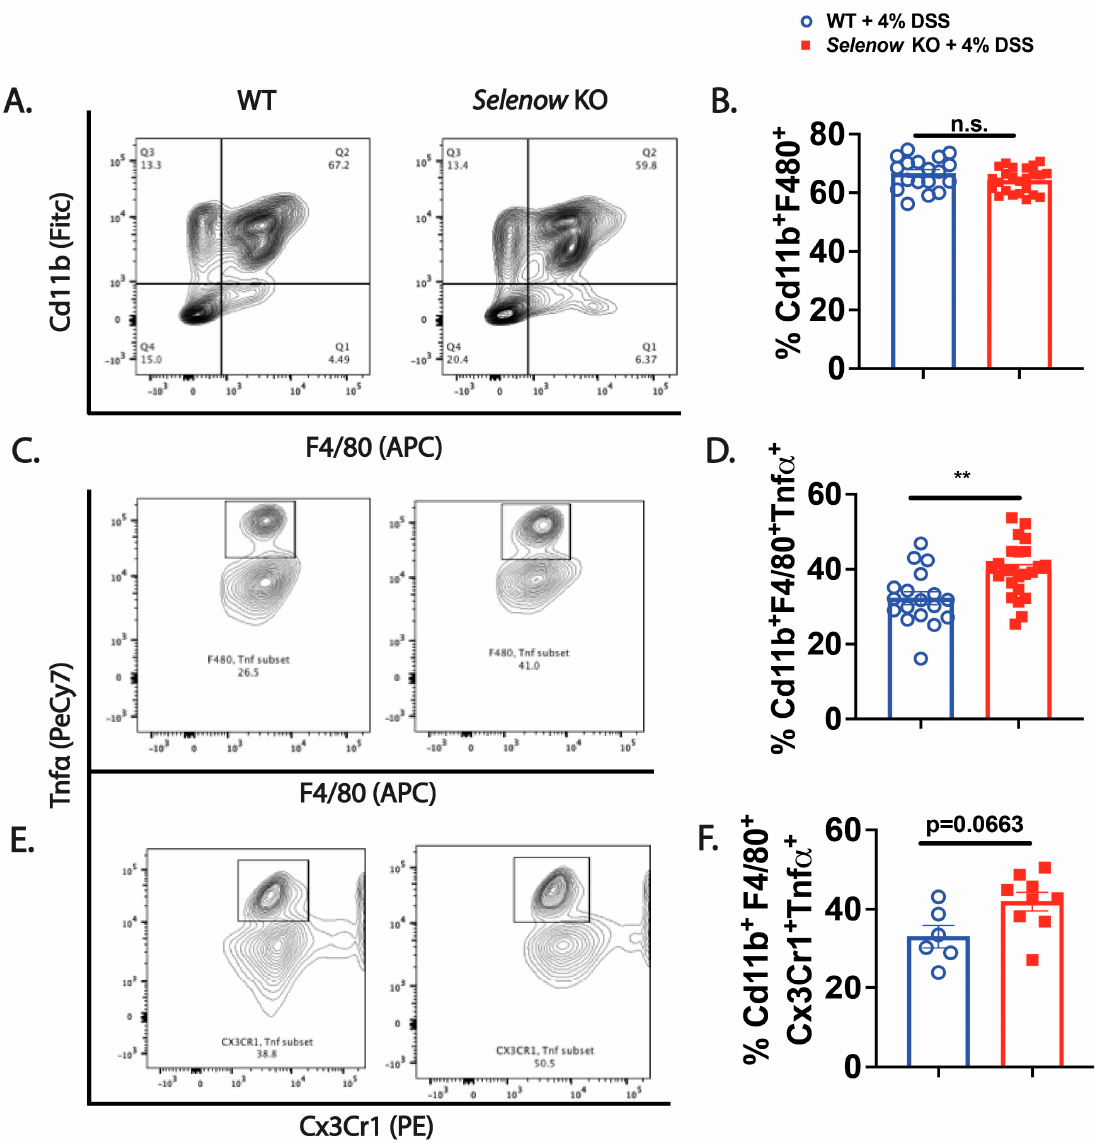
Figure 3. Selenow KO mice have a higher percentage of Tnf α producing macrophages in colonic lamina propria. ( A ) Representative flow plot and ( B ) percentage of macrophages (CD45 + CD11b + F4/80 + ) isolated from cLP of WT and Selenow KO mice at day 8 post DSS (WT = 18 mice; Selenow KO = 24). ( C ) Representative flow plot and ( D ) percentage of macrophages (CD45 + CD11b + F4/80 + ) producing Tnf α isolated from cLP of WT and Selenow KO mice at day 8 post DSS (WT = 18 mice; Selenow KO = 24). ( E ) Representative flow plot and ( F ) percentage of Cx3Cr1 macrophages (CD45 + CD11b + F4/80 + Cx3Cr1 + ) producing Tnf α isolated from cLP of WT and Selenow KO mice at day 8 post DSS (WT = 6 mice; Selenow KO = 9). Data indicate mean ± SEM. ( B , D , F ) Unpaired non-parametric Mann–Whitney test. ** p < 0.01, n.s., not